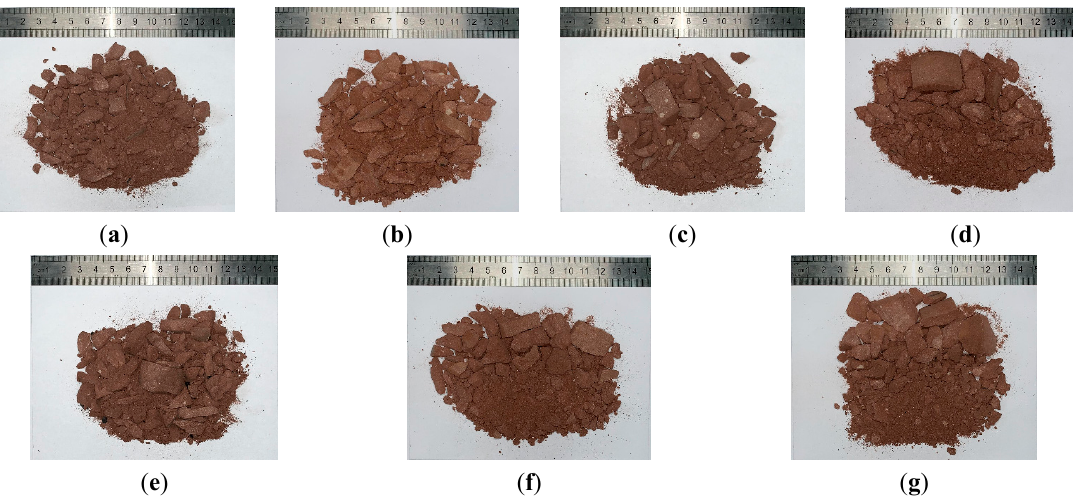
Figure 17. The breakage conditions of the rock specimens under a 0.35 MPa impact pressure in the SHPB test: ( a ) R1-8-1, ( b ) R6-1-2-1, ( c ) R6-2-2-1, ( d ) R7-1-2-1, ( e ) R7-2-2-1, ( f ) R8-1-2-1 and ( g ) R8-2-2-1.